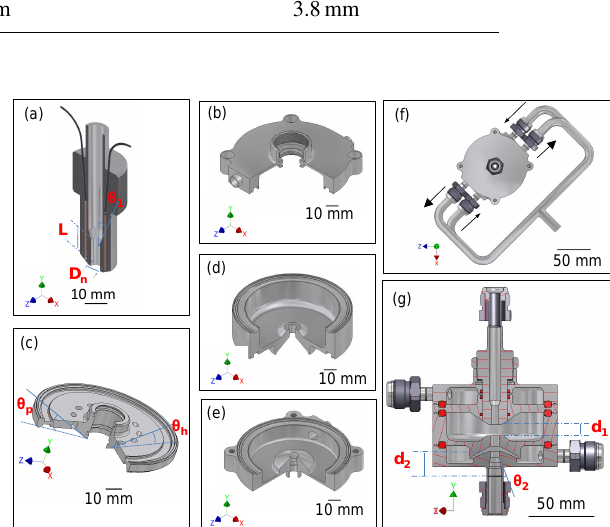
Figure 2. Structure of individual components of the IS-PCVI (from top to bottom) is shown in panels (a) to (e) . Panel f represents the top view, displaying the tangent angle of two pump outlets. This new feature helps minimize the turbulent flow and particle losses. Panelg shows the cross section of the IS-PCVI. A total of eight geo- metrical parameters used for the CFD simulations (see also Table 1) are also